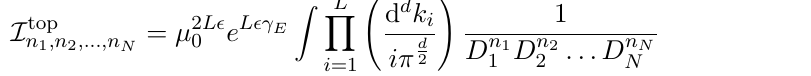
Figure 1 . Sample three loop diagrams contributing to the process q ¯ q → Q